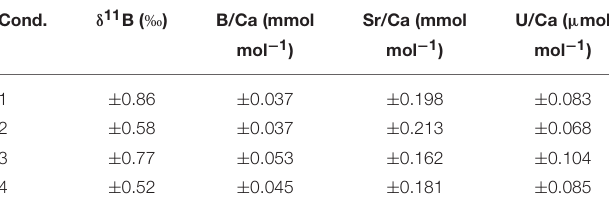
TABLE 3 | Primary polyp juvenile A. millepora reproducibility in each experimental condition. Cond.